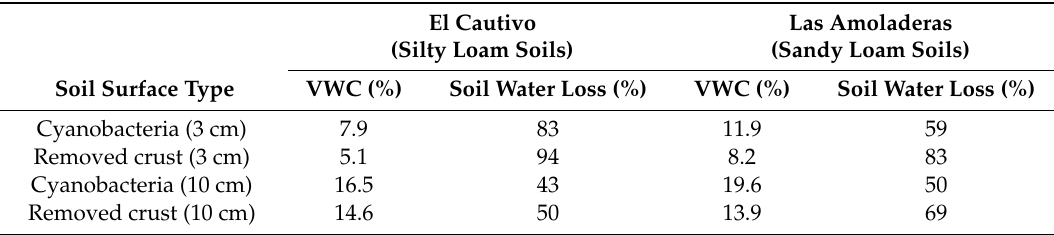
Table 3. Average volumetric water content (VWC, %) and soil water loss (VWC max − VWC min / VWC max , %) at 3 and 10 cm in soils with well-developed cyanobacterial biocrusts and soils after crust removal during a drying period (from 28 September to 28 November) following a rainfall (20 mm) occurred immediately after the biocrust was scraped o ff . El Cautivo Las Amoladeras (Silty Loam Soils) (Sandy Loam Soils) Soil Surface Type VWC (%) Soil Water Loss (%) VWC (%) Soil Water Loss (%) Cyanobacteria (3 cm) 7.9 83 11.9 59 Removed crust (3 cm) 5.1 94 8.2 83 Cyanobacteria (10 cm) 16.5 43 19.6 50 Removed crust (10 cm) 14.6 50 13.9